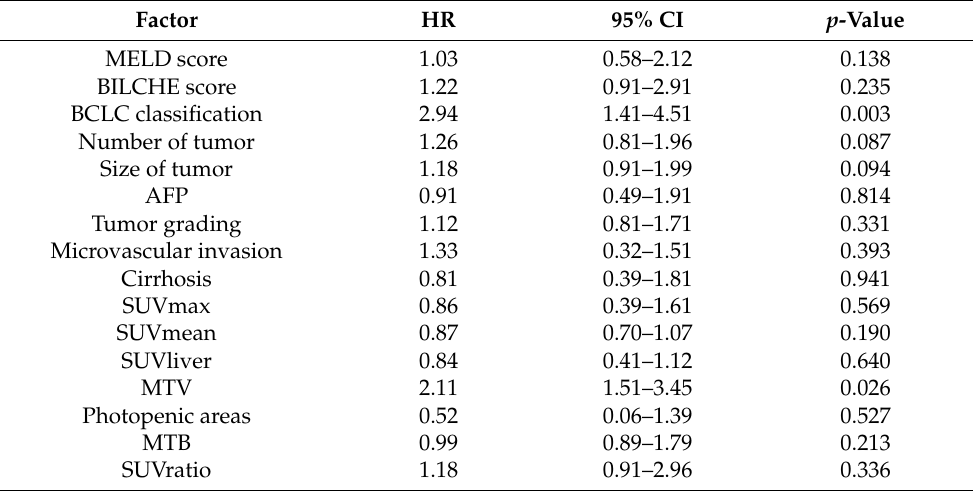
Table 4. Multivariate analysis of prognostic factors for overall survival